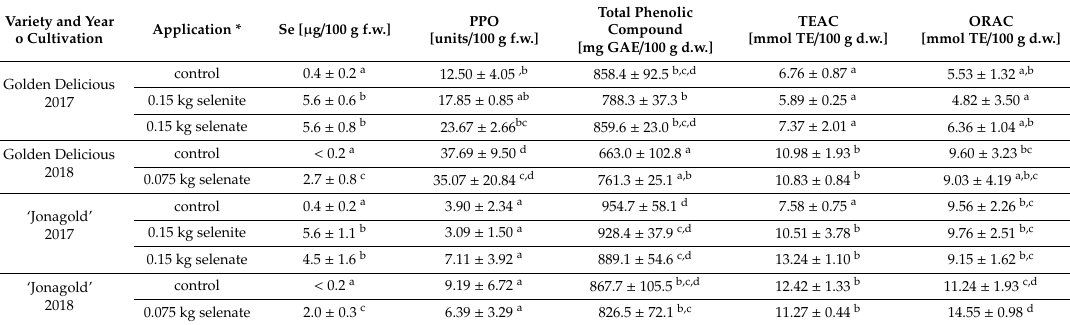
Table 1. Results of the determination of the selenium content, polyphenol oxidase activity, total phenolic content, and antioxidant activity in all apple samples. Data are given as mean value ± standard deviation ( n = 4). In each column, means followed by different letters are significantly different ( p < 0.05). TotalPhenolic TEAC ORAC VarietyandYear µ g / 100gf.w.] PPO Compound oCultivation Application* Se[ [units / 100gf.w.] [mmolTE / 100gd.w.] [mmolTE / 100gd.w.] [mgGAE / 100gd.w.]